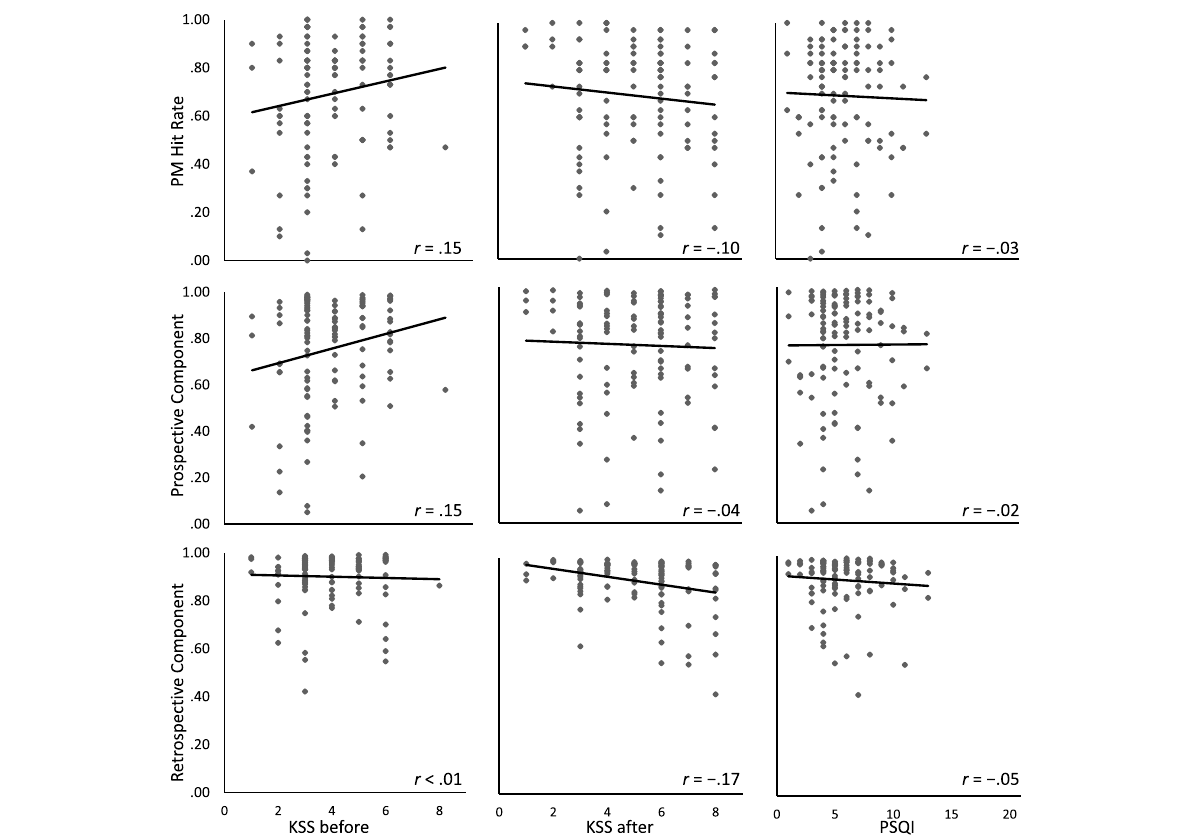
Fig. 2 Scatterplots and correlations between the Karolinska Sleepiness Scale (KSS) ratings, the Pittsburgh Sleep Quality Index (PSQI), and the prospective-memory (PM) measures. Note that high KSS scores indicate strong subjective sleepiness, whereas high PSQI scores indicate low subjective sleep